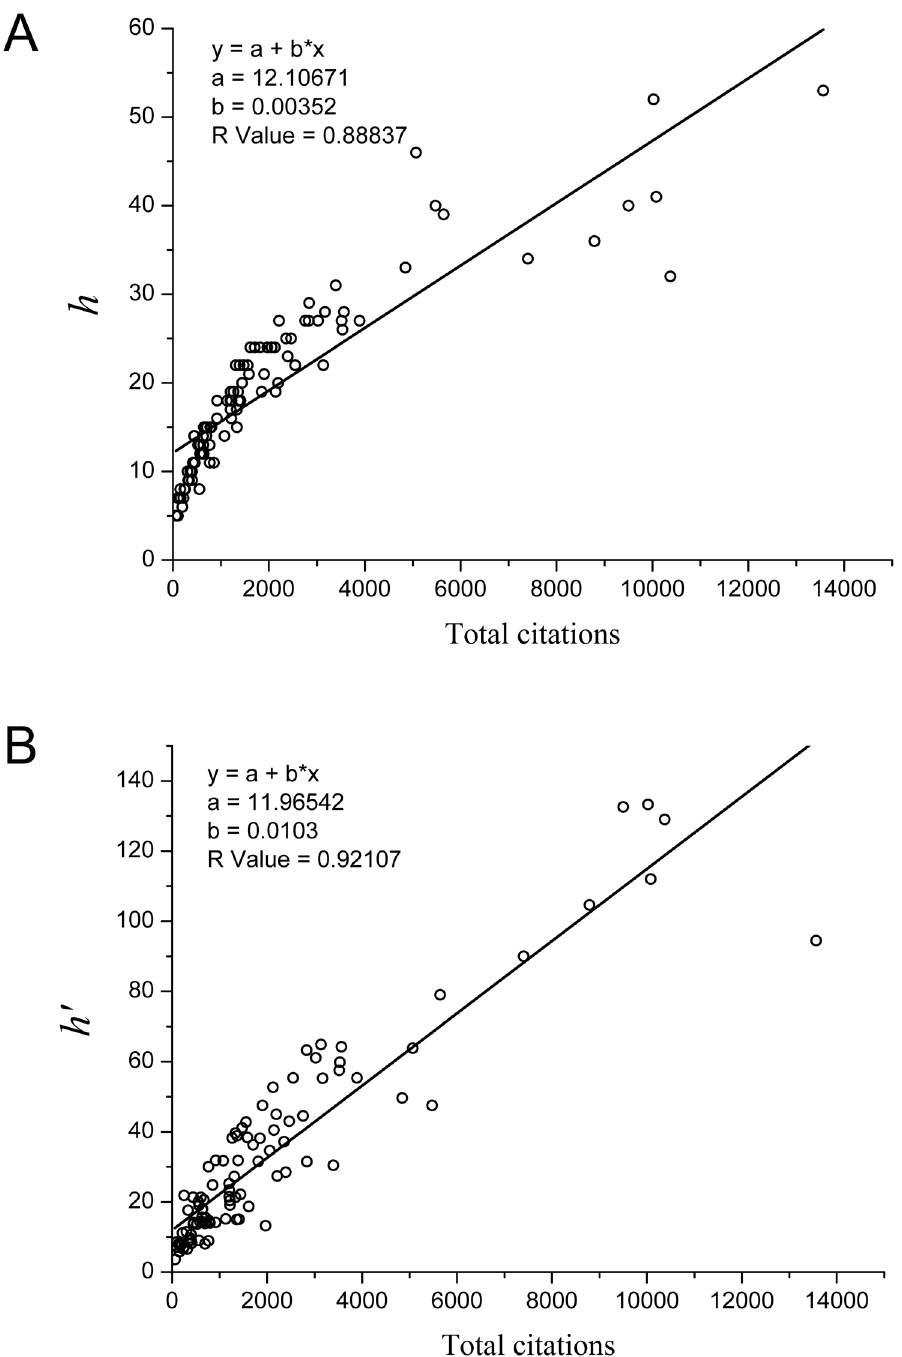
Figure 2. The correlation between the h- index and the h ’ -index with the number of total citations. A, the correlation between the h- index and the number of total citations, and B, the correlation between the h ’ -index and the number of total citations, based on the data of the 100 most prolific economists. Note that the h ’ -index shows better linear correlation with the number of total citations than the h- index.